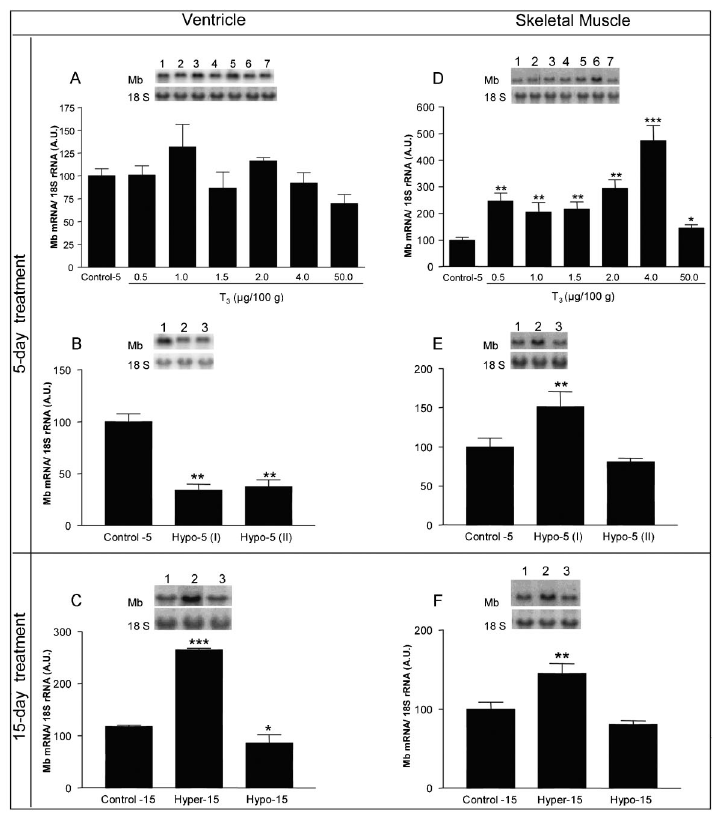
Figure 2. Influence of thyroid hormone on the pattern of Mb gene expression in ventricular and skeletal muscles of rats during 5 and 15 days of postnatal developmental. Northern blot analysis of ventricle and skeletal muscles Mb mRNA levels of rats subjected to T 3 or PTU treatment from P0 through P5 ( A , B , D , and E ) or P15 ( C and F ) is shown at the top of each panel, and the quantitative results obtained by densitometric analysis of Mb and 18s rRNA transcripts hybridization ratio are shown at the bottom, in arbitrary units (A.U.). The effect of increasing doses of T 3 , from P0 to P5, on Mb mRNA expression is shown in A and D , and of the PTU treatment [5 mg = Hypo-5 (I), or 10 mg/100 g BW = Hypo-5 (II)] during the same period, is shown in B and E . Panels C and F show the effect of T 3 (4 m g/100 g BW) and PTU (5 mg/100 g BW) treatment during the first 15 days of postnatal life on Mb mRNA expression. Data are reported as means±SE of 12 animals/group. *P , 0.05, **P , 0.01 and ***P , 0.001 vs control-5 and vs control-15 (one- way